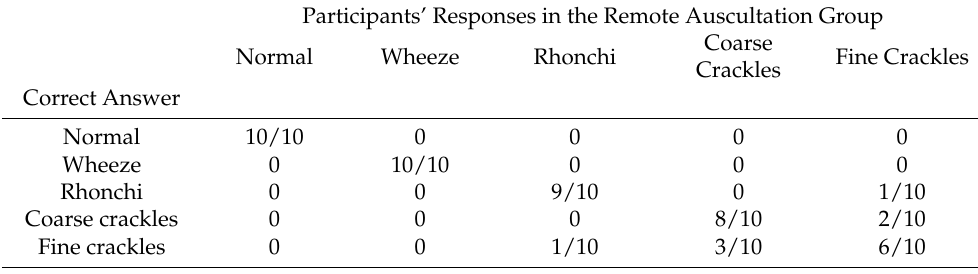
Table 3. Detailed answers in lung